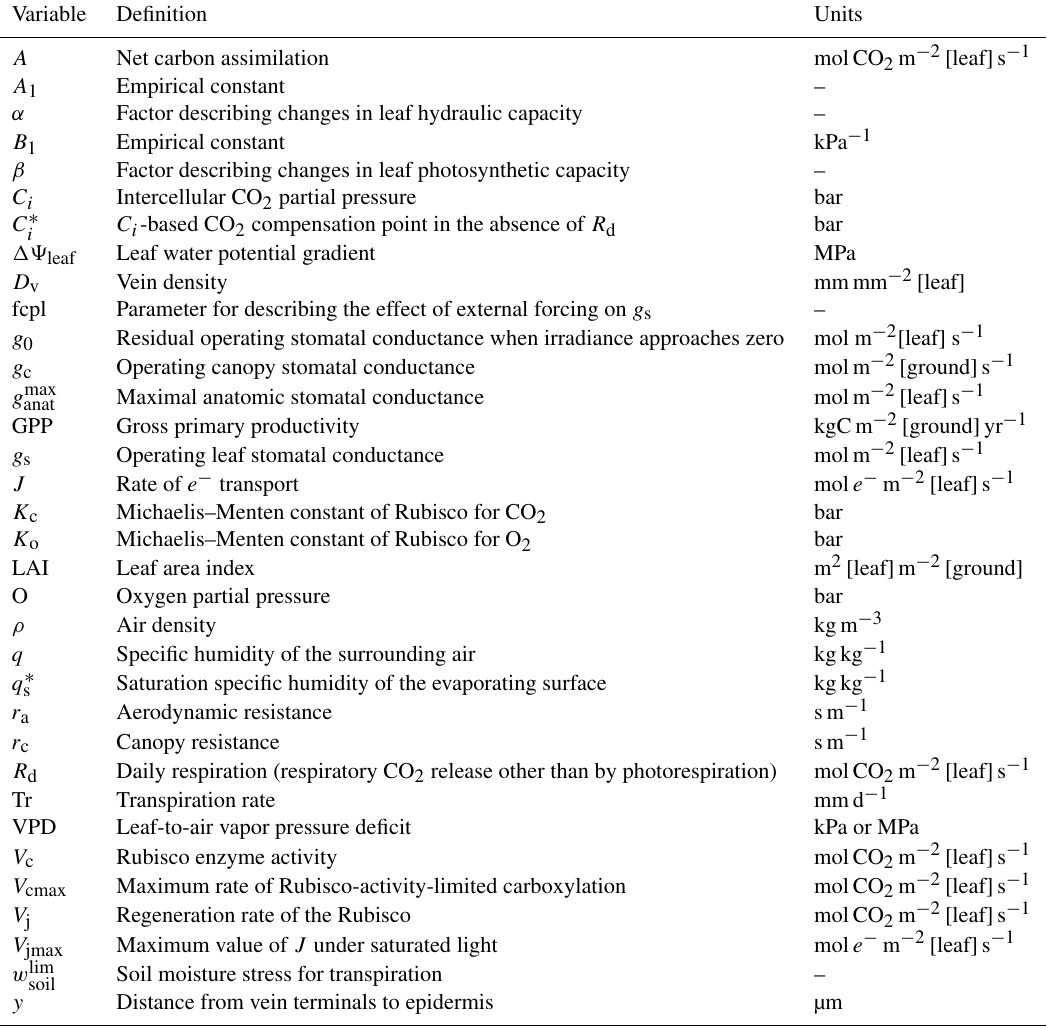
Table 1. List of main variables used in the models and their units.